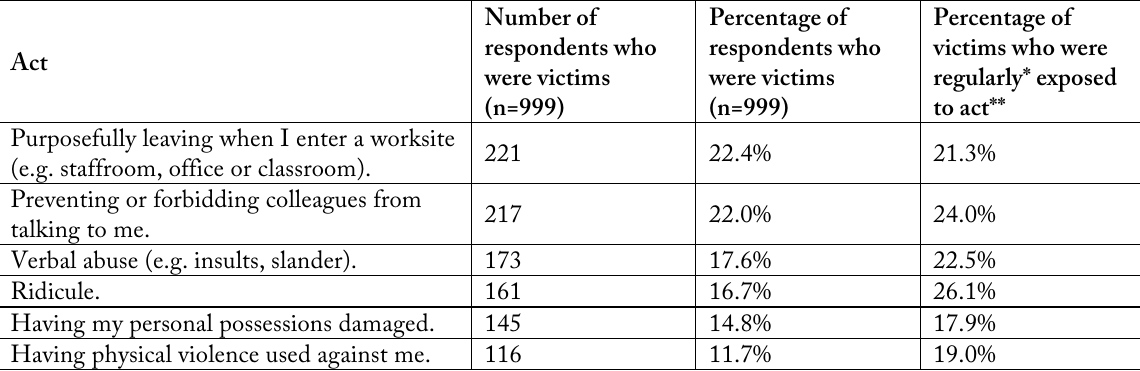
Table 6: Respondents who experienced direct negative behaviour